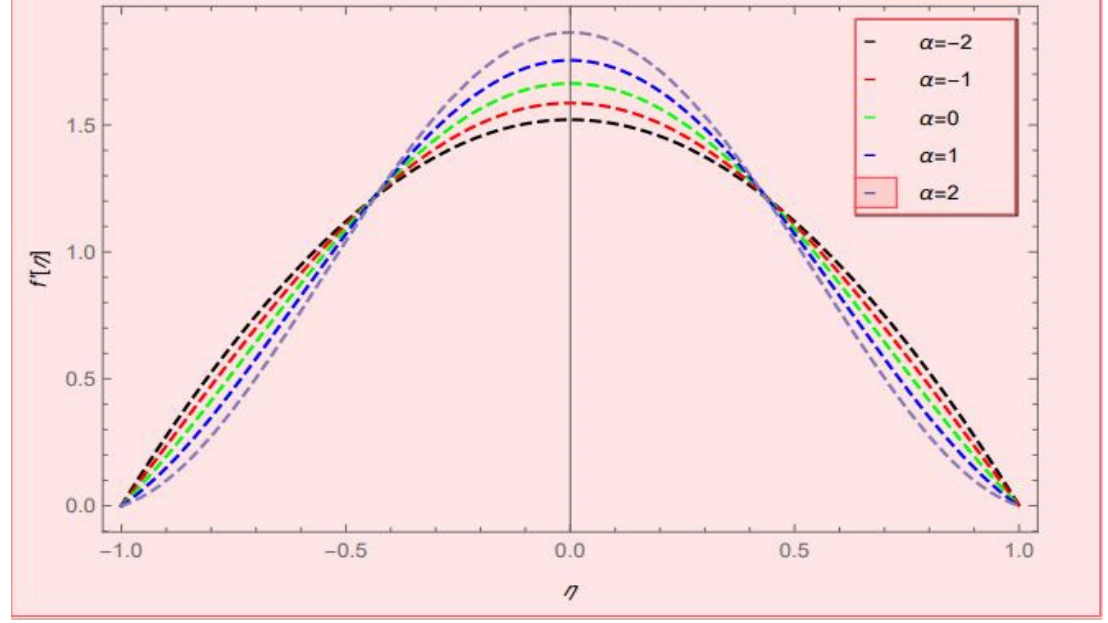
Figure 5. Velocity profile effect against the wall expansion and contraction ratio ( α ) for 𝑅𝑒 = 4, 𝑃𝑟 = 0.1, 𝑁𝑡 = 𝑁𝑏 = 0.7, 𝑀 = 13, 𝛽 = 0.6,𝐵𝑟 = 0.1,𝜑 (cid:2869) = 𝜑 (cid:2870) = 0.02,ℎ = 2,𝑟 = 1.5 .